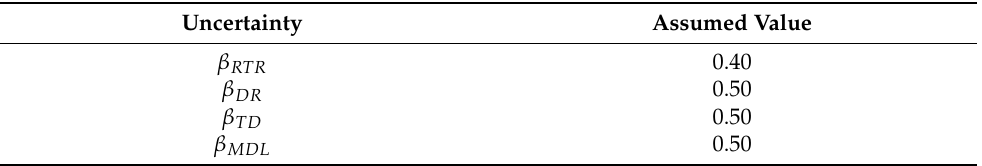
Table 7. Uncertainty values assumed for the determination of total system collapse uncertainty. Adapted from [47].